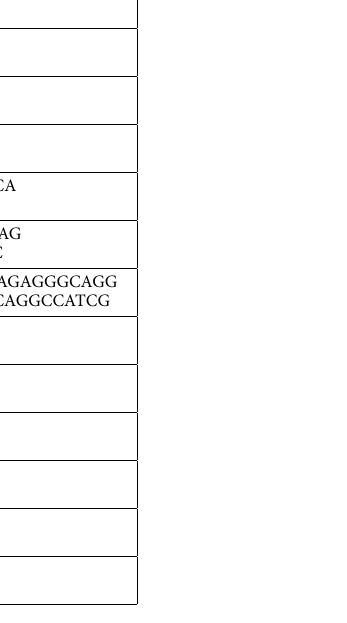
Table 1. Primers used for RT-PCR and genomic